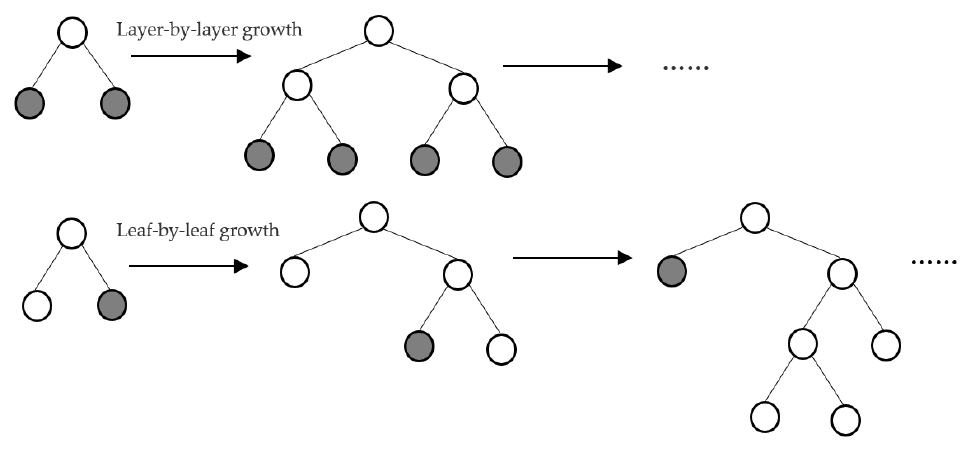
Figure 1. Layer-by-layer growth and leaf-by-leaf growth.